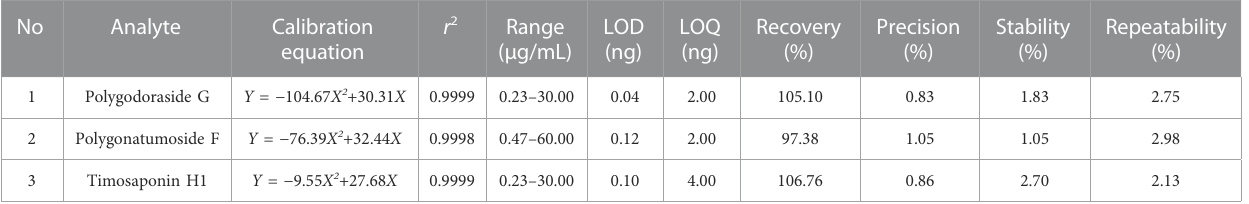
TABLE 2 Calibration curves, linear range, LOD, LOQ, recovery, precision, repeatability, and stability of three investigated analytes in PO. No